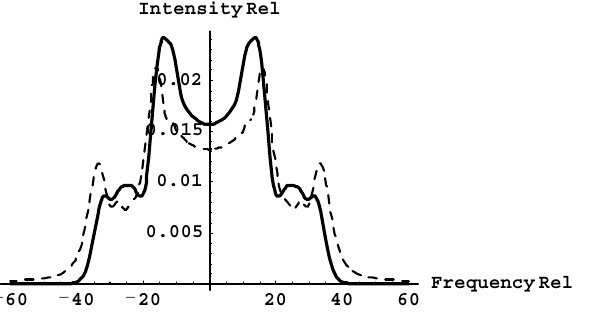
Figure 6. The same as Figure 5 but for even stronger Langmuir waves, corresponding to ε = 6.